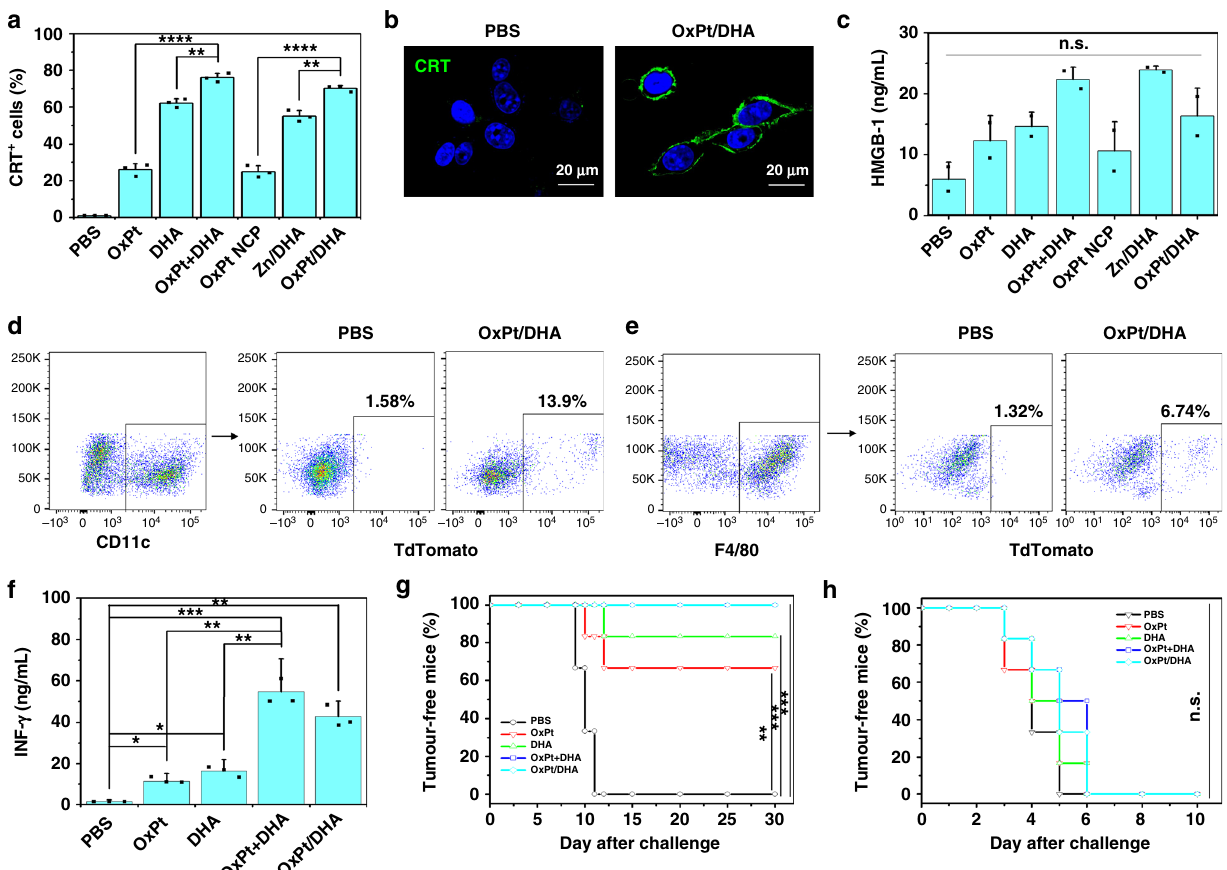
Fig. 5 Immunostimulatory effects in colorectal cancer cells. a , b CRT cell surface expression upon treatment with OxPt/DHA, determined by fl ow cytometry ( a ) and CLSM ( b ). c HMGB-1 release from tumour cells treated with OxPt/DHA, detected by ELISA. d – f Uptake of treated MC38 cells by bone- marrow-derived dendritic cells ( d ) and macrophages ( e ). f Priming of T-cell responses triggered by OxPt/DHA. MC38 tumour cells were treated with OxPt/DHA, and injected into the right footpads of C57BL/6 mice to determine the capacity of draining lymph node cells to produce IFN- γ in response to MC38 lysates. g , h In vivo anticancer vaccination of OxPt/DHA in immunocompetent C57BL/6 mice ( g ) and immunode fi cient Rag 2 − / − mice ( h ). The antitumour response was measured by immunizing mice with OxPt/DHA-treated tumour cells in one fl ank and challenging mice with untreated, live tumour cells in the opposite fl ank 7 days later. Data are expressed as means ± SD. One of three repetitions with similar results is shown here for ( a ) − ( e ). The result was obtained without repetition for ( f ) − ( h ) ( n = 6). * p < 0.05, ** p < 0.01, *** p < 0.001, **** p < 0.0001 by Student ’ s two-tailed t test.